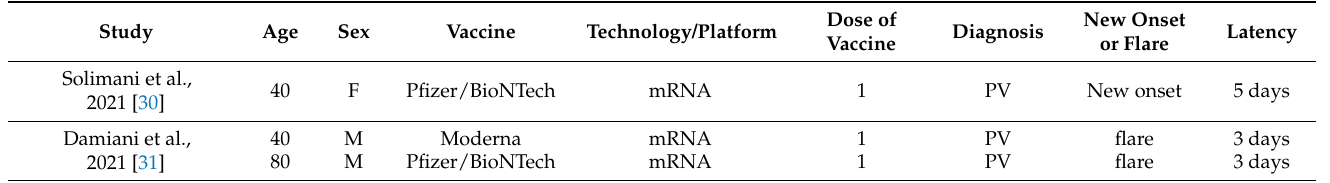
Table 1. Summary of pemphigus onset/flare following SARS-CoV-2 vaccination in published